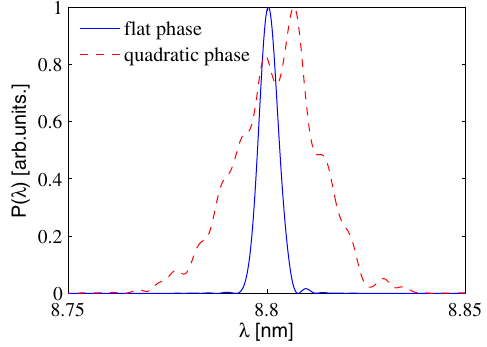
FIG. 15. Spectra of 30th harmonic radiation pulses of EEHG for the 80 fs seed laser pulses with flat phase (blue solid line) and quadratic phase (red dashed